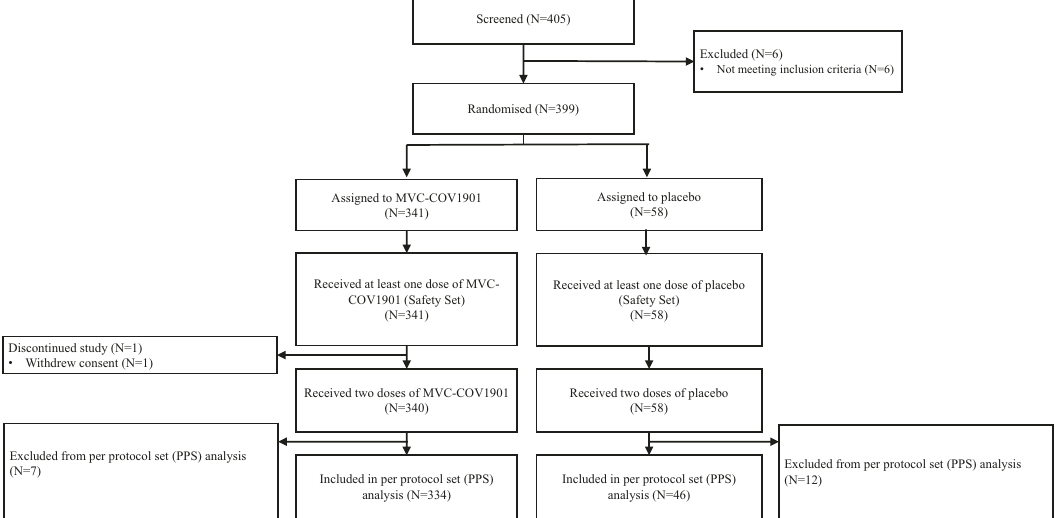
Fig. 1 CONSORT Flow diagram of the study. Participants were enrolled from July 21, 2021 to December 22, 2021. The safety population included all participants who received at least one dose of the MVC-COV1901 vaccine or placebo. The per protocol set (PPS) population consisted of participants who received the two doses of MVC-COV1901 or placebo as scheduled, and were seronegative at baseline with anti- nucleocapsid (anti-N) antibodies negative at Visit 2 and Visit 6, and did not have a major protocol deviations. Detailed reasons for exclusion from the PPS can be found in Supplementary Table